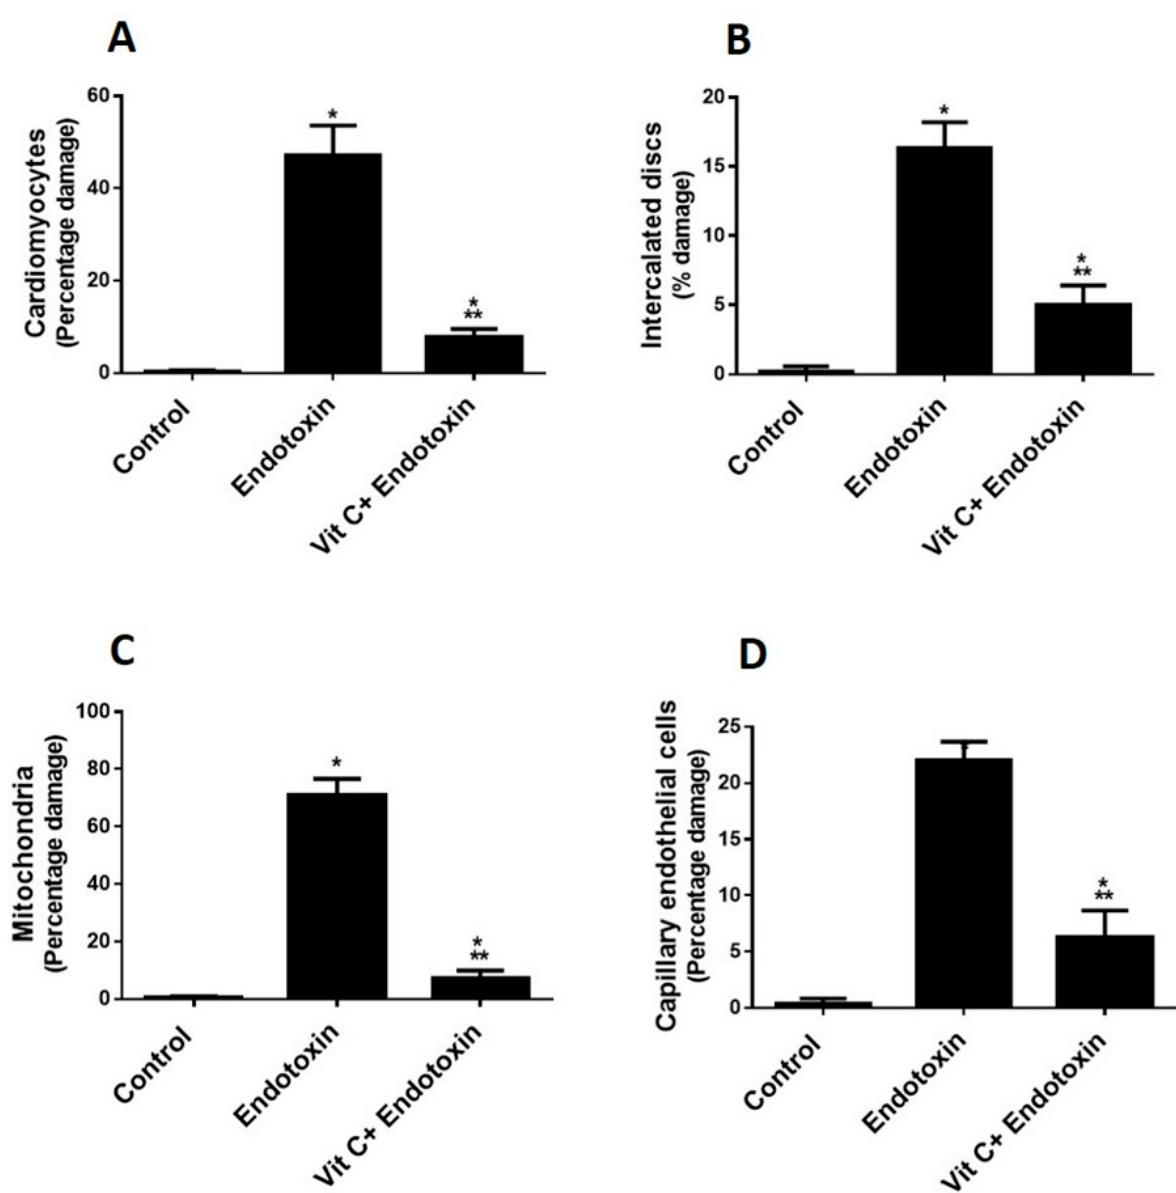
Figure 6. The percentage of TEM cardiac, mitochondrial, capillary endothelial damage. Vit C protects against endotoxin-induced cardiomyocytes ( A ), intercalated discs ( B ), mitochondrial ( C ) and capillary endothelial cell ( D ) damage. * p < 0.05 when compared to the controls, *** p < 0.05 in contrast to endotoxin group.